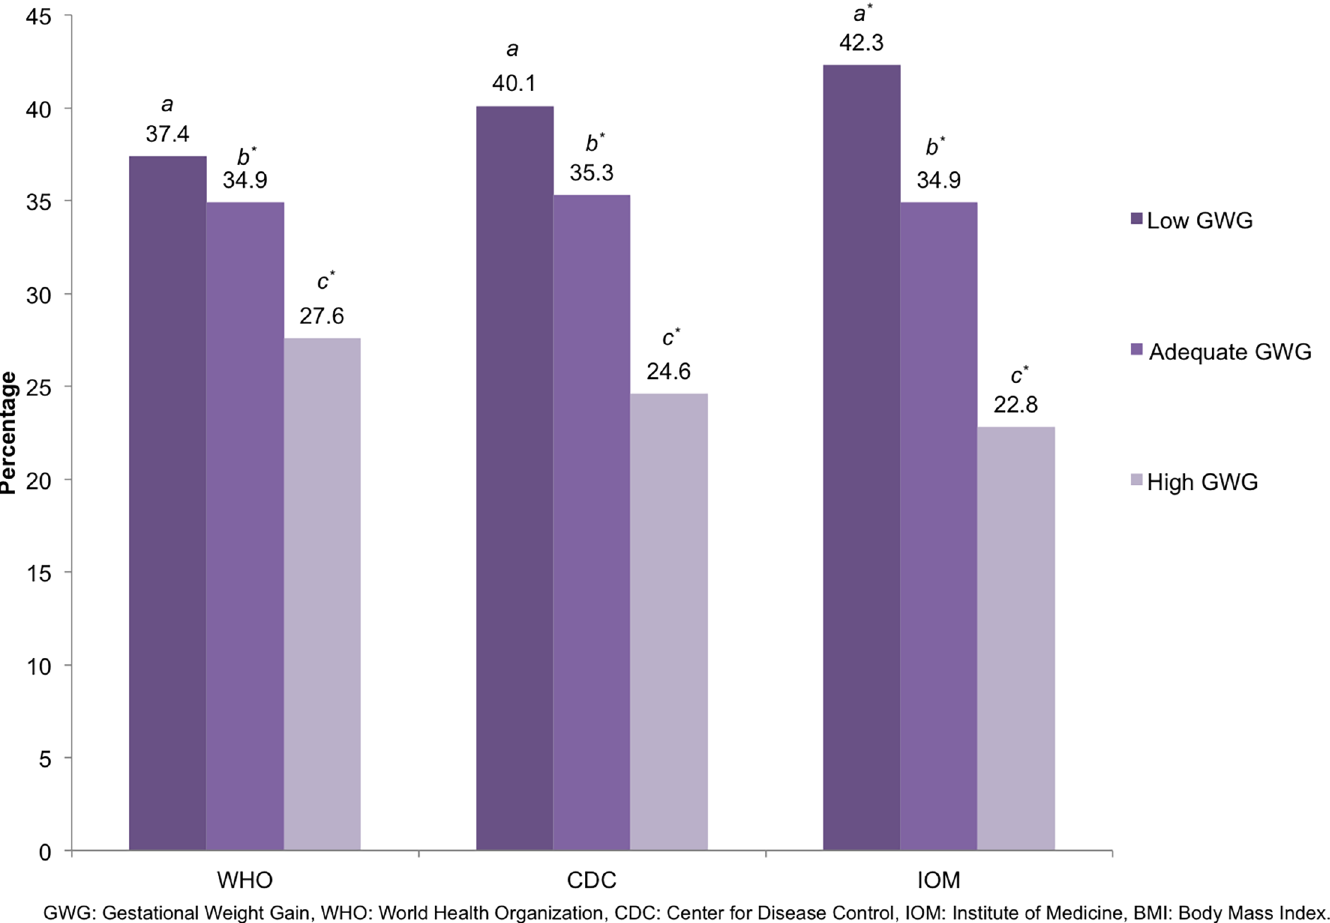
Fig 2. Gestational weight gain according to IOM recommendation, using three different criteria of pre-pregnancy BMI classification.